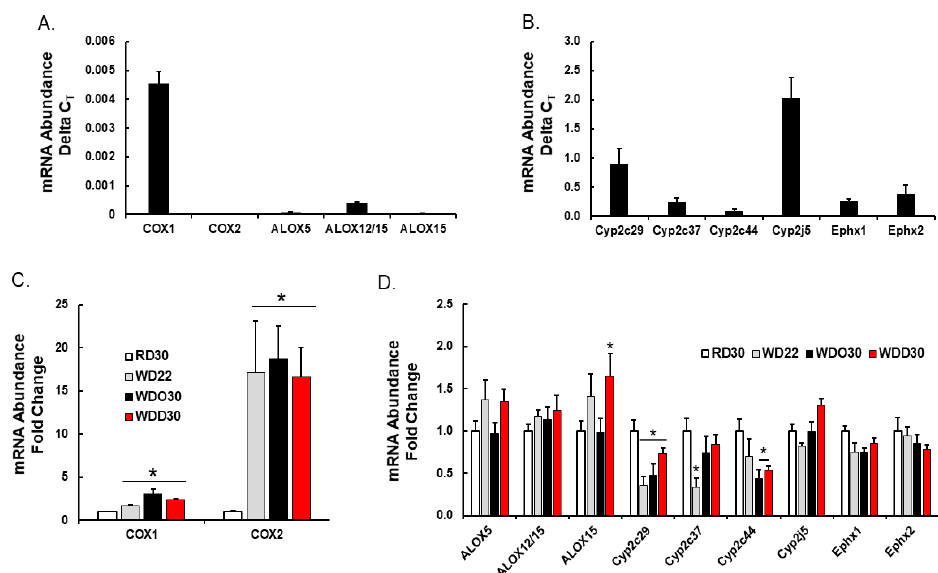
Figure 7. Diet e ff ects on hepatic enzymes involved in oxylipin metabolism. Hepatic RNA was extracted, converted to cDNA and used to quantify transcript abundance using qRTPCR as previously described [52]. The primers used to measure each transcript were previously described [51,60]. Cyclophilin was used as the reference gene. (Top panels A , B ): Relative abundance of transcripts encoding enzymes involved in hepatic oxylipin metabolism. Results are presented as delta C T , mean ± SEM. (Lower panels C , D ): Diet e ff ects on hepatic transcripts encoding enzymes involved in oxylipin metabolism. Results are presented as Fold Change, mean ± SEM; *, q < 0.05 vs. RD30. COX, cyclooxygenase; ALOX, arachidonic lipoxygenase; CYP, cytochrome P450, Ephx1, microsomal epoxide hydrolase; Ephx2, soluble epoxide hydrolase.